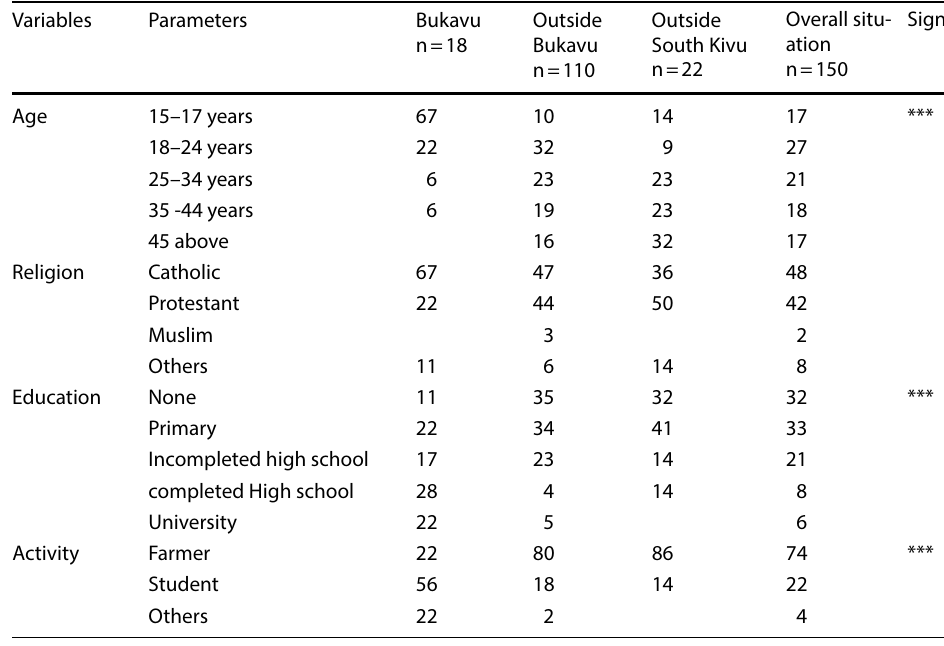
Table 2 Sociodemographic characteristics of victims